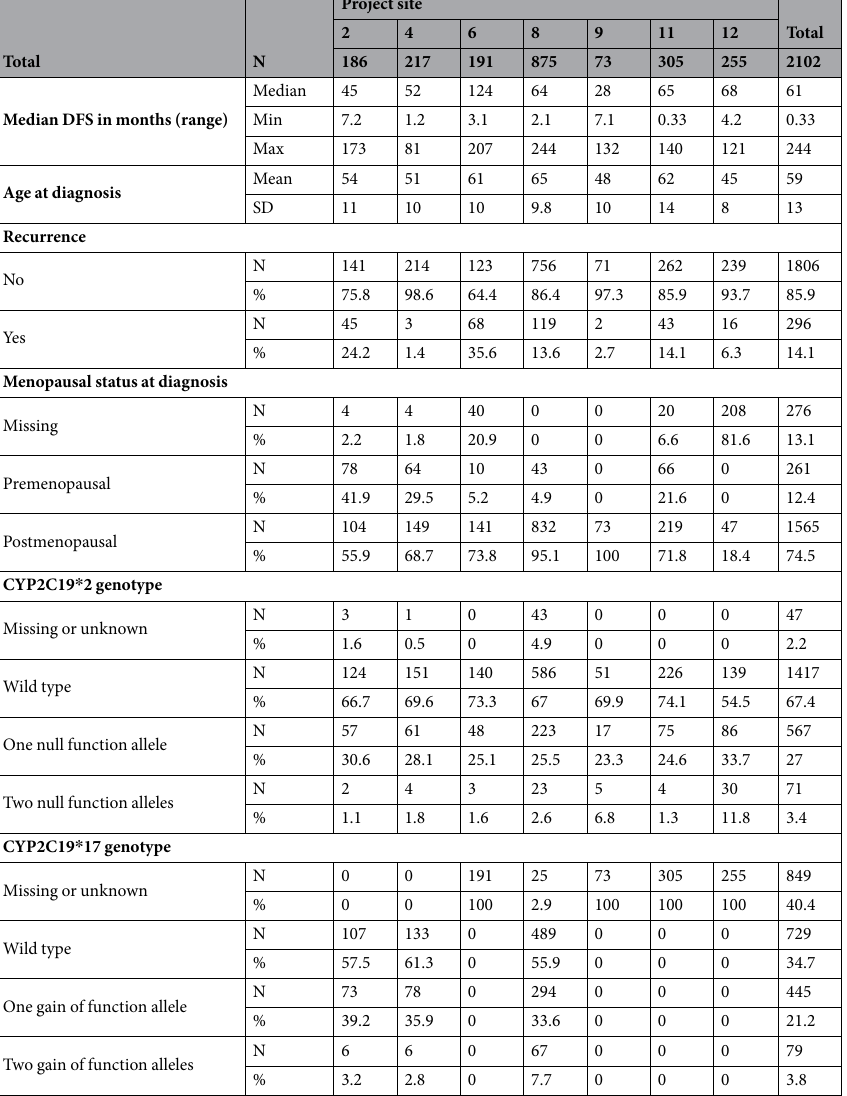
Table 2. Sample population characteristics.